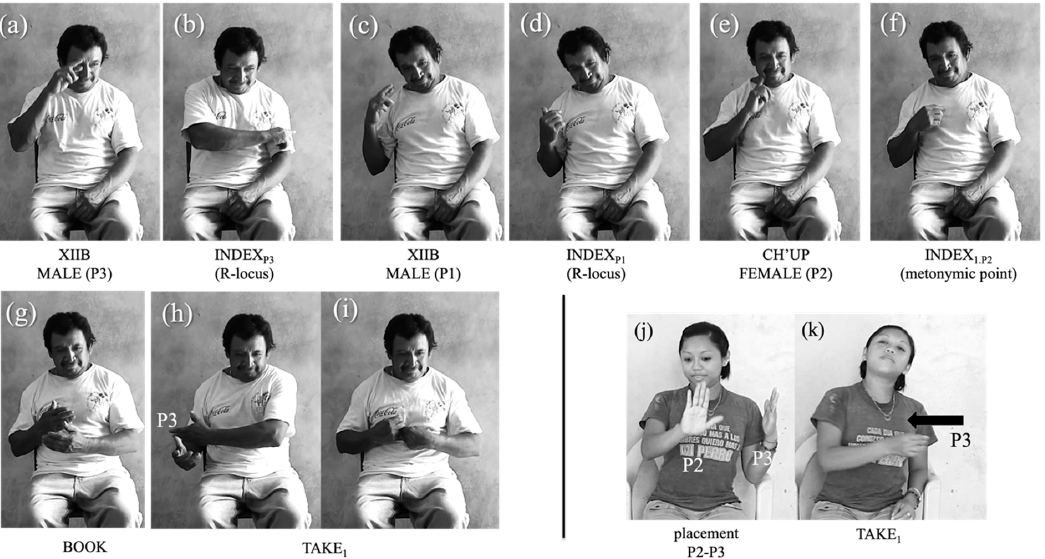
Figure 6. Responses using single agreement verbs (( a – i ) signer of 1st generation from Chicán; ( j , k ) signer of 1st generation from Nohkop) ( a – i ) “there is a man here, a man here (and) a woman where I am, from P3 I take the book”; ( j , k ) “P2 and P3 are thusly placed, from P3 I take the book”.